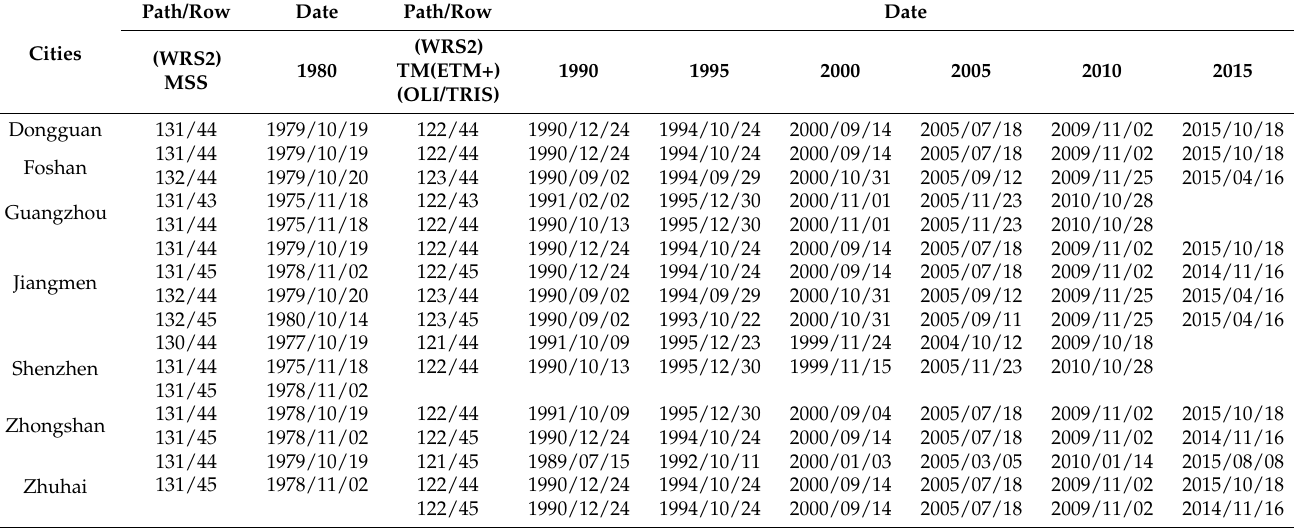
Table 2. Information of used remoting sensing data (original data acquired from NASA).